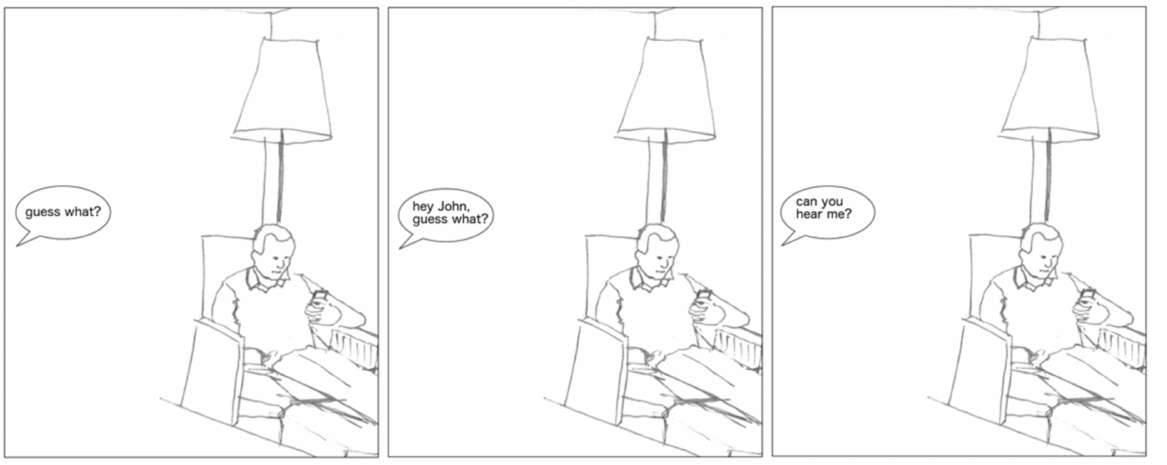
Figure 1. Magazine situation.